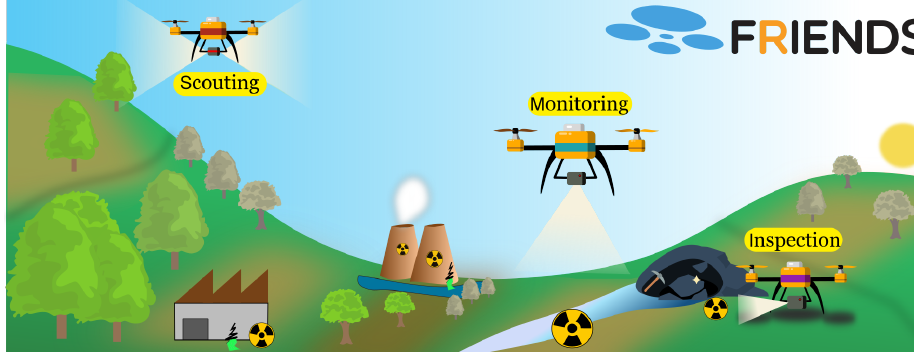
Figure 1. Missions are divided into three major phases: Scouting, Monitoring,